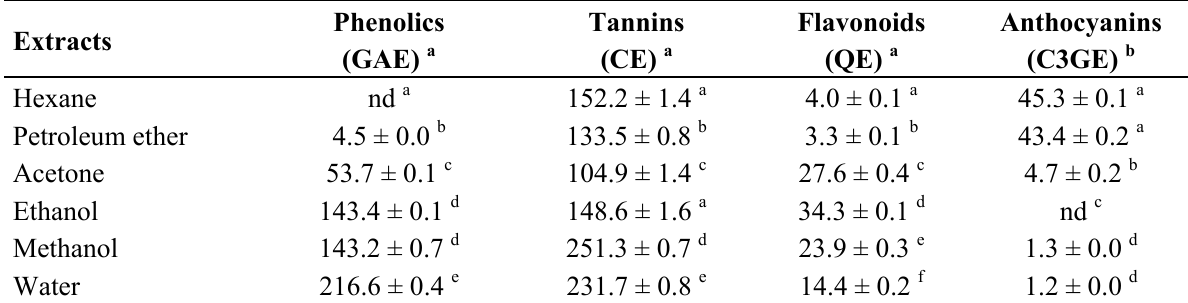
Table 3. Chemical composition of E. gillii extracts